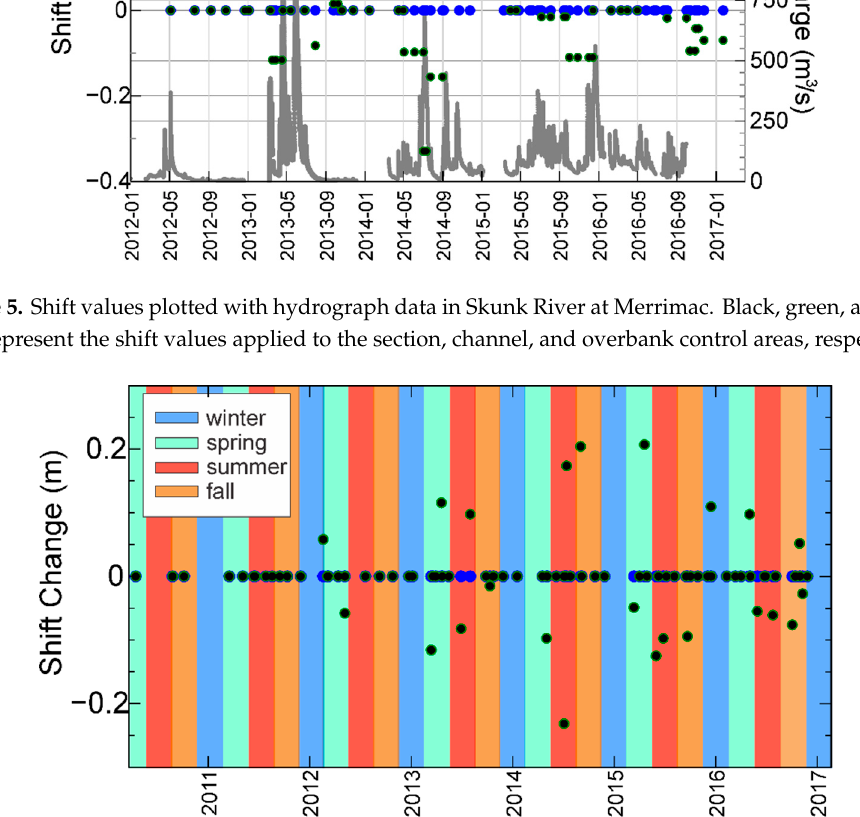
Figure 6. Shift change value as function of the season in Skunk River at Merrimac. Black, green, and blue dots represent the shift values applied to the section, channel, and overbank control areas, respectively.